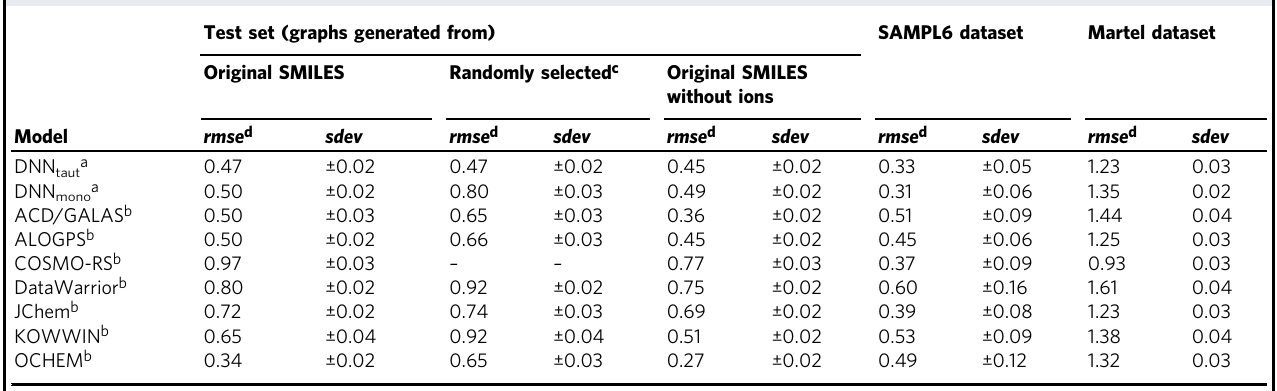
Table 1 Comparison of the performance of our developed DNNs and other prediction tools. Test set (graphs generated from) SAMPL6 dataset Original SMILES Randomly selected